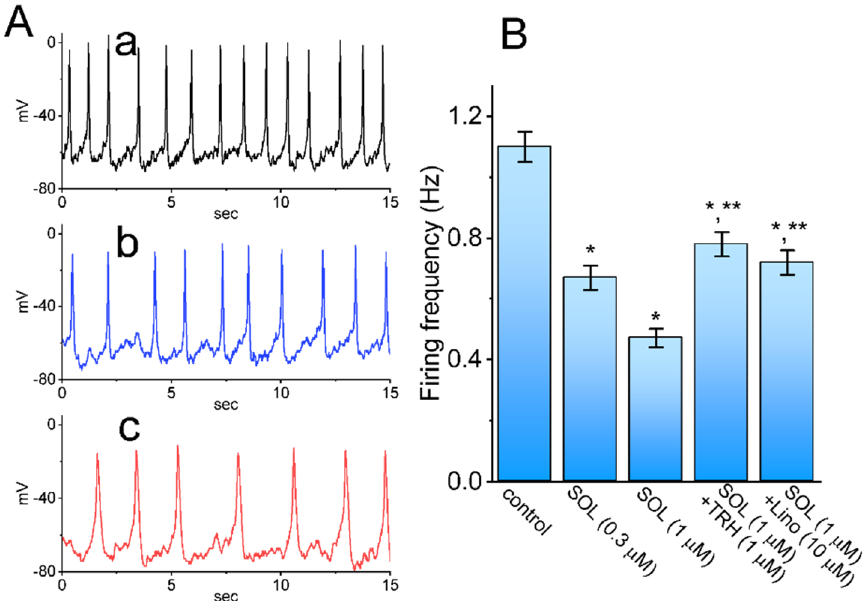
Figure 8. Effect of SOL on spontaneous action potentials (APs) recorded from GH 3 cells. Whole-cell current-clamp potential recording was carried out in this series of measurements. ( A ) Representative potential traces obtained in the control period (a) and during cell exposure to 0.3 µ M SOL (b) or 1 µ M SOL (c). ( B ) Summary bar graph showing effect of SOL, SOL plus TRH and SOL plus Lino on firing frequency of APs (mean ± SEM; n = 8 for each bar). Data analysis was made by ANOVA-1 ( p < 0.05). * Significantly different from control ( p < 0.05) and ** significantly different from SOL (1 µ M) alone group ( p < 0.05).